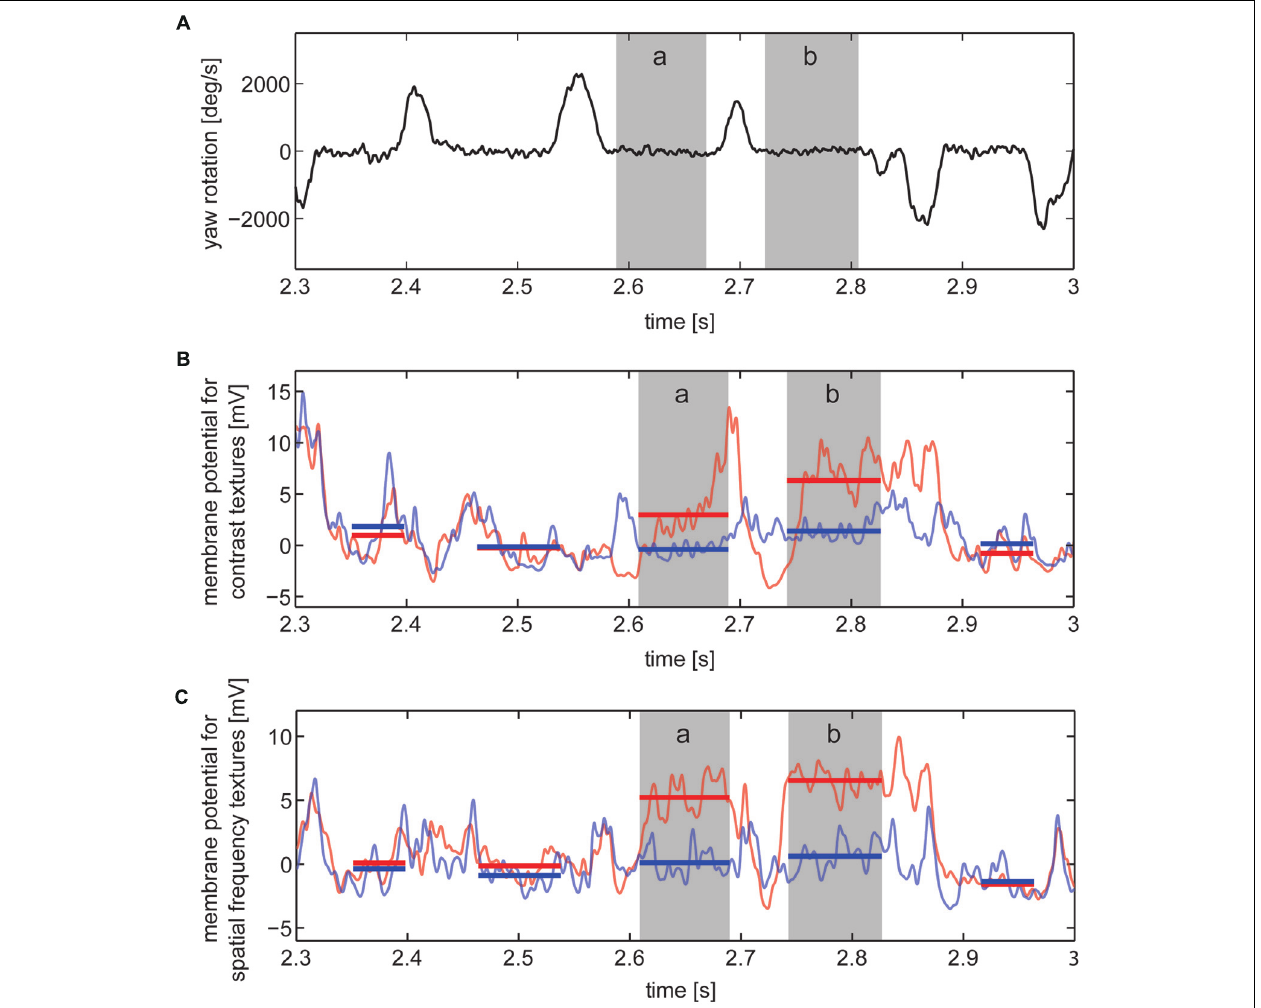
obtained from one example cell to stimuli of “no-object condition” (light blue) and “object condition” (light red). Intersaccadic responses to “no-object condition” (blue) and “object condition” (red) marked by horizontal lines covering the periods of every intersaccadic interval within this section of the cell response. (B) Cell responses to contrast defined stimuli and (C) to stimuli defined by spatial frequency